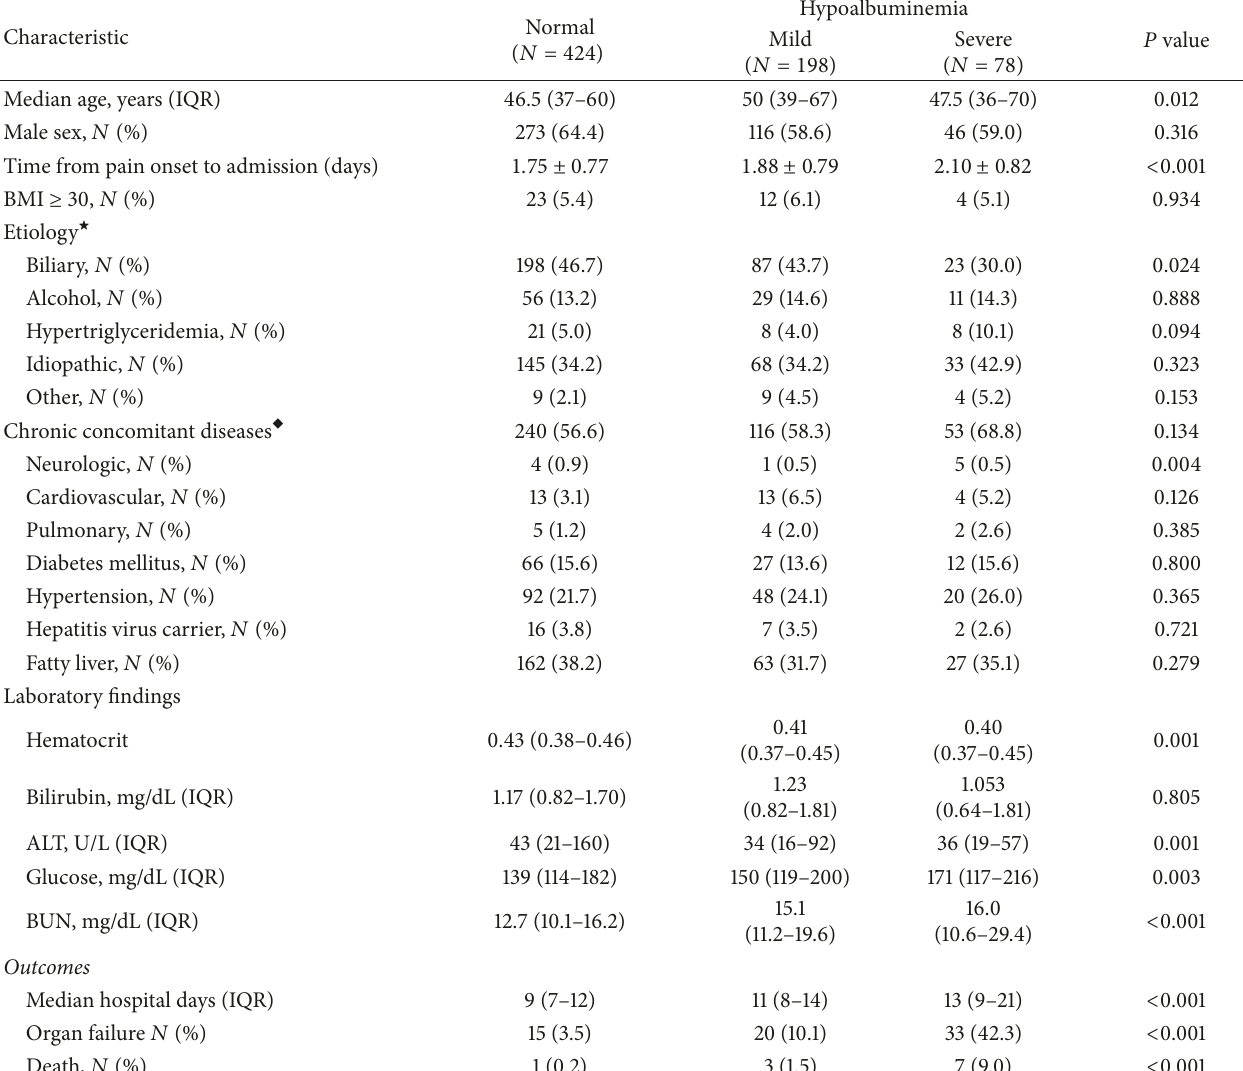
Table 1: Baseline clinical characteristics and outcomes among patients with different albumin